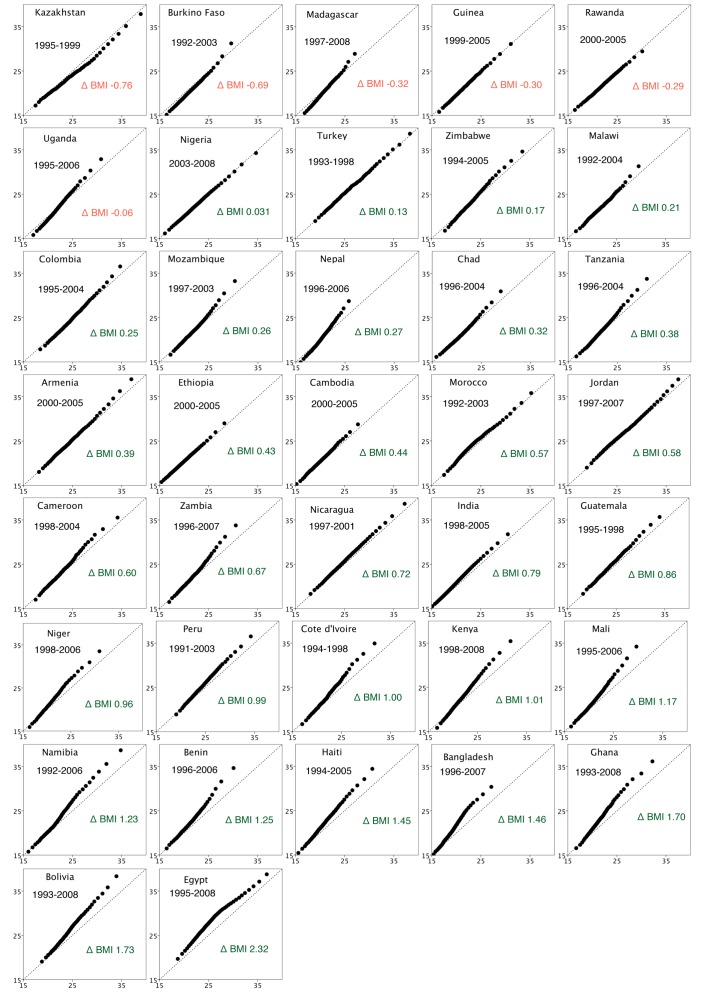
QQ plots of BMI in 37 countries.Country plots are ordered in terms of increasing mean weight between baseline and final survey, from smallest to largest. x-axis BMI at the baseline survey; y-axis BMI at final survey cycle. The diagonal line y = x is the line of equality between baseline survey and final survey. Δ BMI, change in mean BMI from first survey to last survey. Red text indicates decline in mean BMI; green text indicates increase in mean BMI.